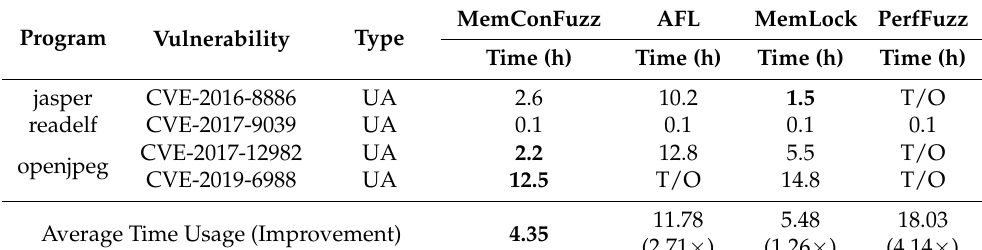
Table 2. Trigger time of real-world